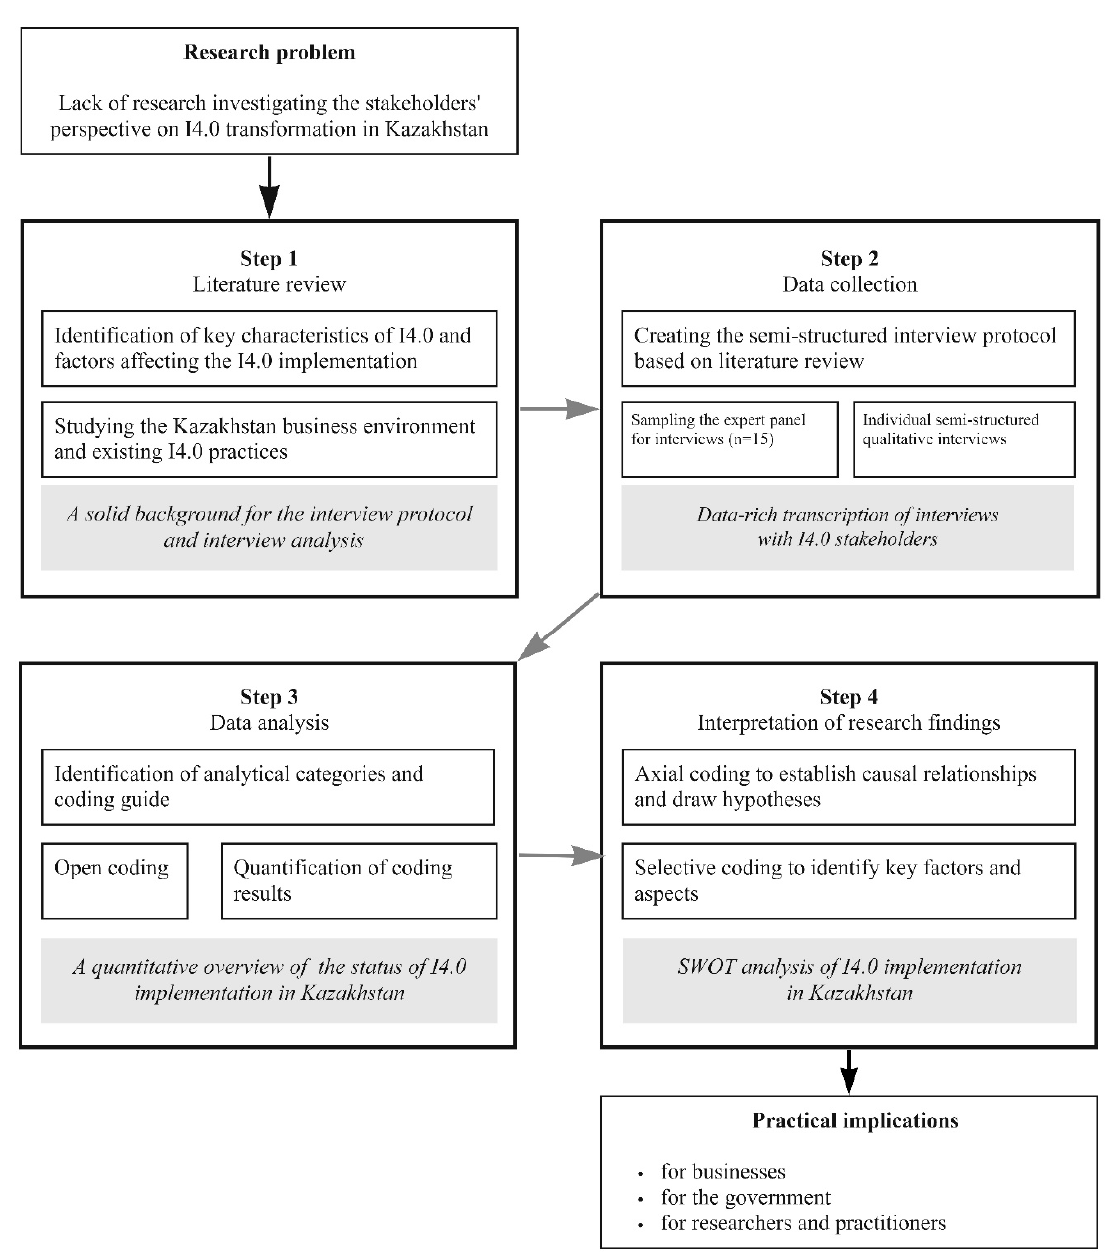
Figure 1. An overview of systematic stakeholder analysis stages.